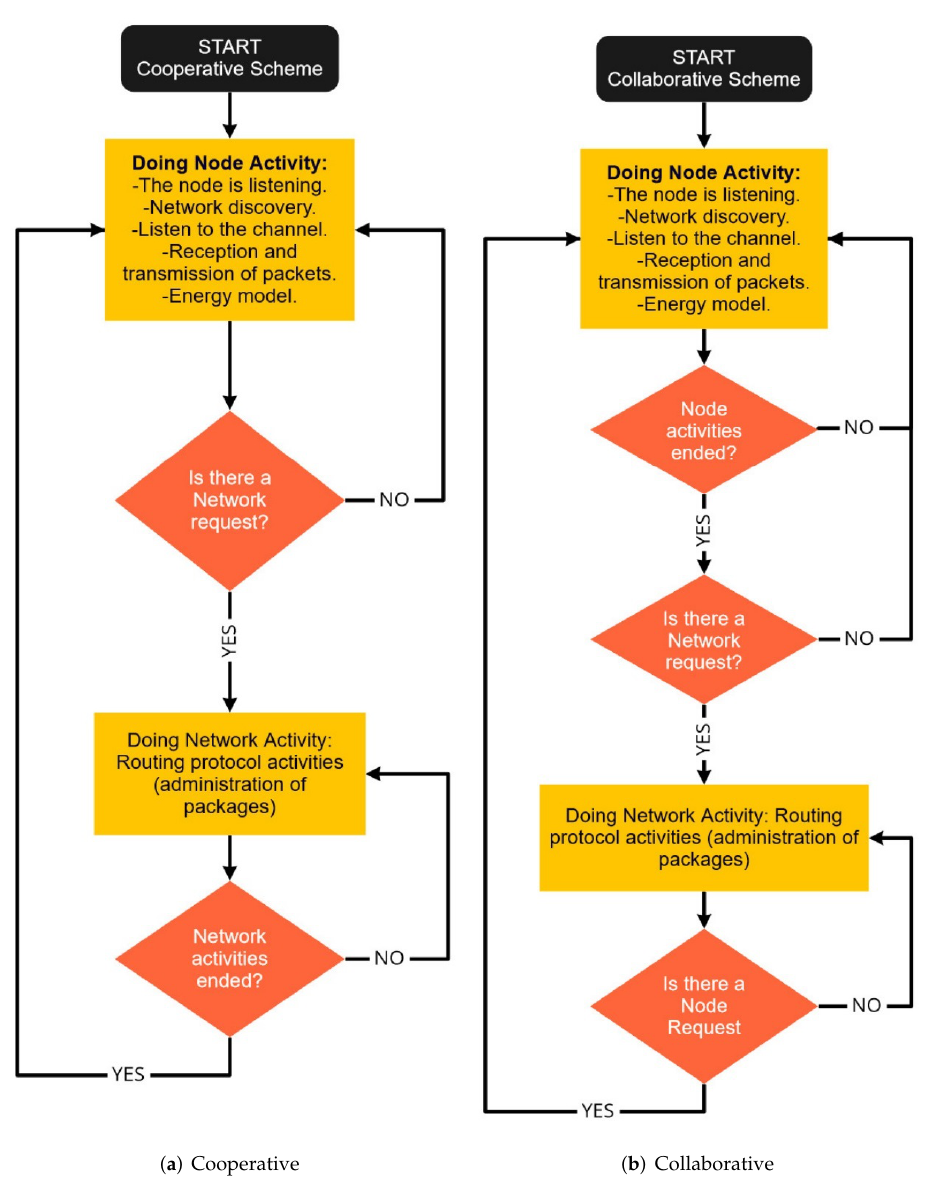
Figure 2. Schemes for